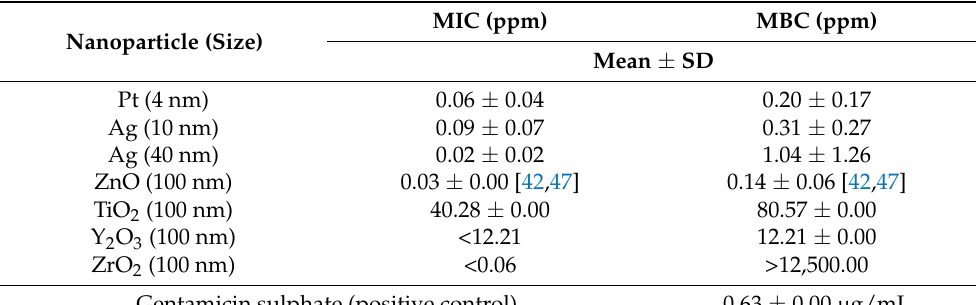
Table 2. Results of antimicrobial activity investigation of metal and metalo oxide nanoparticles on